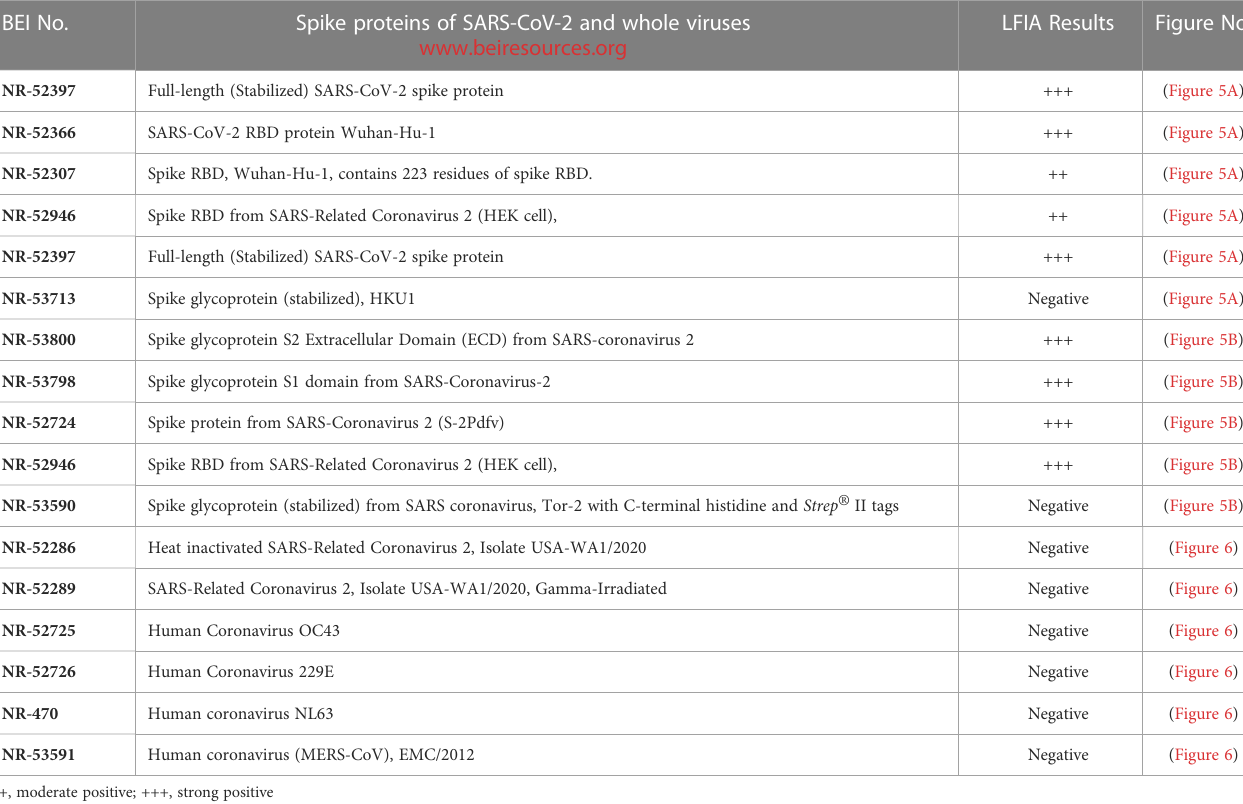
TABLE 1 LFIA Speci fi city with full-length Spike/RBD proteins of SARS-CoV-2 and whole viruses. BEI No. Spike proteins of SARS-CoV-2 and whole viruses www.beiresources.org